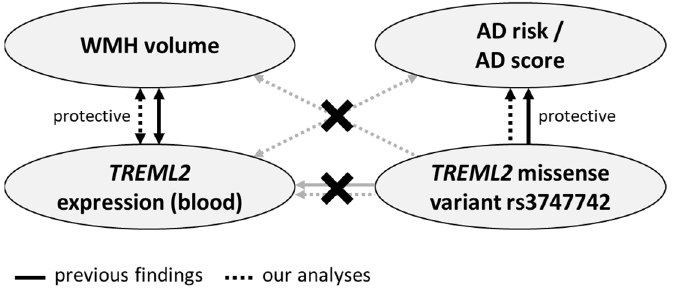
Figure 2. Overview of previous findings and the results of the current analyses. Crossed-out lines illustrate that no significant association has been detected. Summarized, both in our and previous studies, associations between WMH volume and whole-blood TREML2 expression as well as AD risk and rs3747742 were detected, while rs3747742 was not found to be a whole-blood eQTL of TREML2 in either. In addition to previous studies, we searched for cross-relations, but found none.